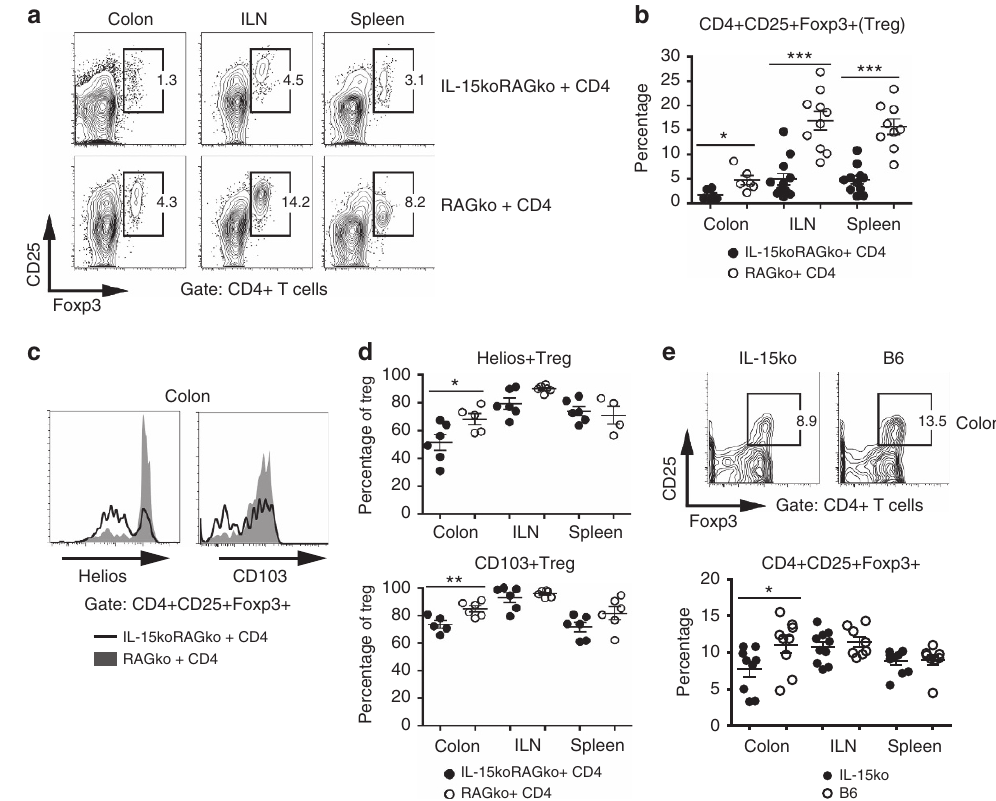
Figure 4 | IL-15koRAG2ko mice with colitis have diminished percentage and altered phenotype of Treg. ( a – e ) About 2 (cid:3) 10 5 CD4 þ T lymphocytes from B6 mice were transferred into RAG2ko or IL-15koRAG2ko mice killed 4 weeks later. ( a ) Expression of CD25 and Foxp3 on CD4 þ Tcells in the injected IL-15koRAG2ko and RAG2ko mice. ( b ) Frequency among live CD4 þ Tcells of CD4 þ CD25 þ Foxp3 þ Tcells (Treg) recovered from adoptively transferred IL-15koRAG2ko and RAG2ko mice. ( c ) Expression of Treg-related markers: Helios and CD103 by Treg cells isolated from the colon of IL-15koRAG2ko (black line) and from RAG2ko recipient mice (grey shadow). ( d ) Frequency among Treg (CD4 þ CD25 þ Foxp3 þ ) of Helios- (upper panel) and CD103 (lower panel) -expressing cells recovered from the injected IL-15koRAG2ko and RAG2ko mice. ( b – d ) Open circles RAG2ko mice; black circles: IL-15koRAG2ko mice. ( e ) Expression of CD25 and Foxp3 on CD4 þ T cells in the colon of unmanipulated IL-15ko or B6 mice (upper panel) and frequency among live CD4 þ Tcells of CD4 þ CD25 þ Foxp3 þ Treg in the colon, the ILN and the spleen of unmanipulated IL-15ko or B6 mice (lower panel). Data compiled from two separate experiments with at least three mice per group. Each symbol represents an individual mouse. All graphs indicate means; error bars denote s.e.m.; Student’s t -test values: * P o 0.05; *** P o